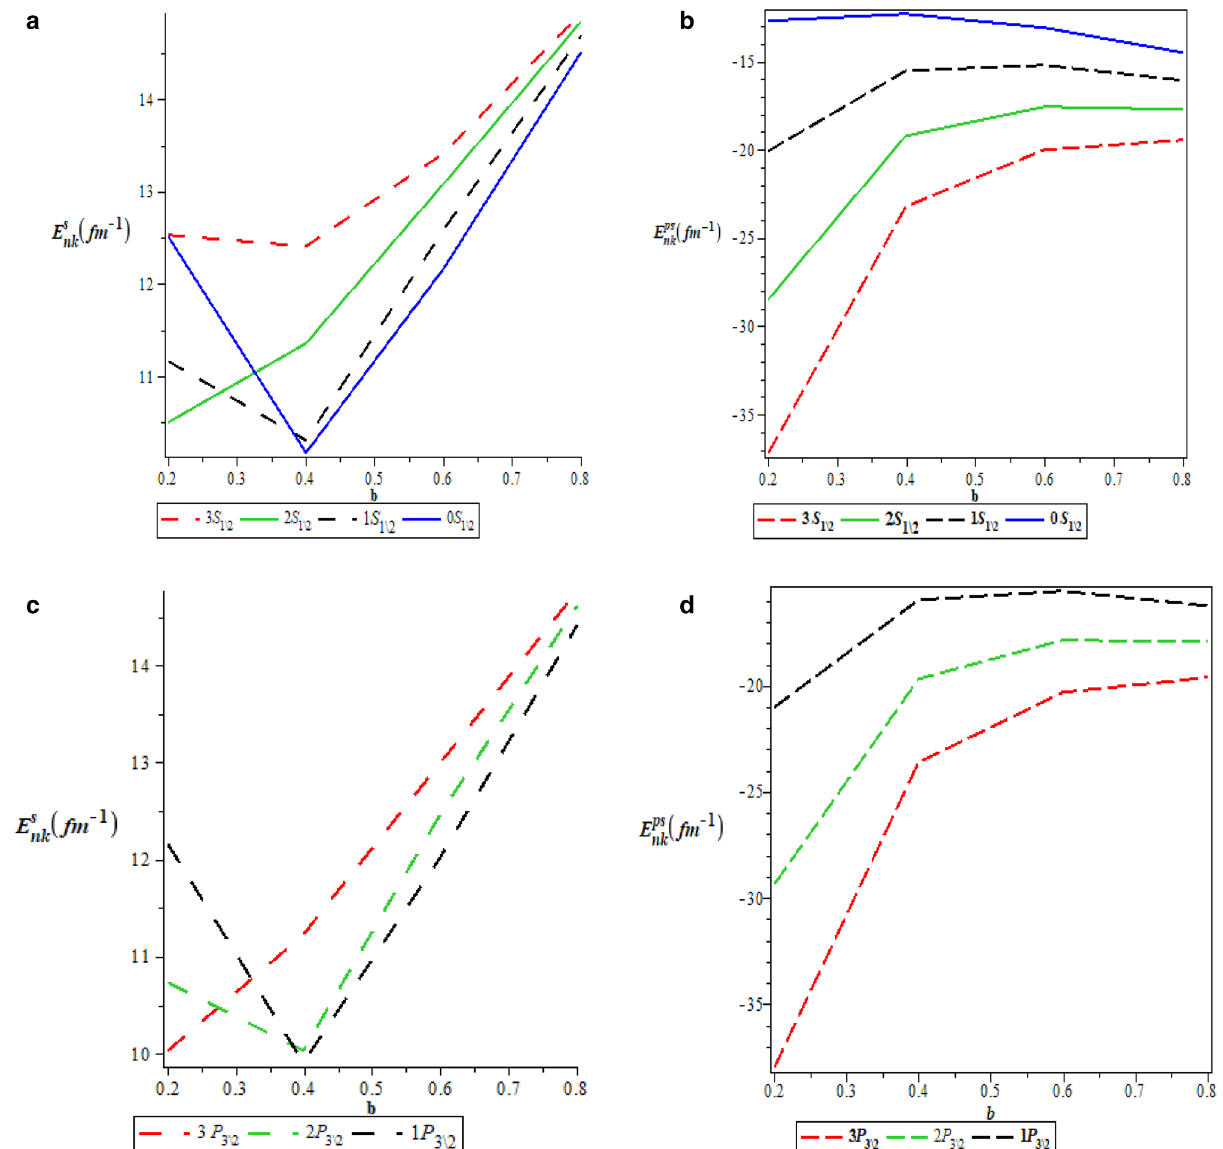
Figure 3. ( a ) Variation of Energy Spectra for S-spin Symmetry. ( b ) Variation of Energy Spectra for S-pseudospin Symmetry. ( c ) Variation of Energy Spectra for P-spin Symmetry. ( d ) Variation of Energy Spectra for P-pseudospin